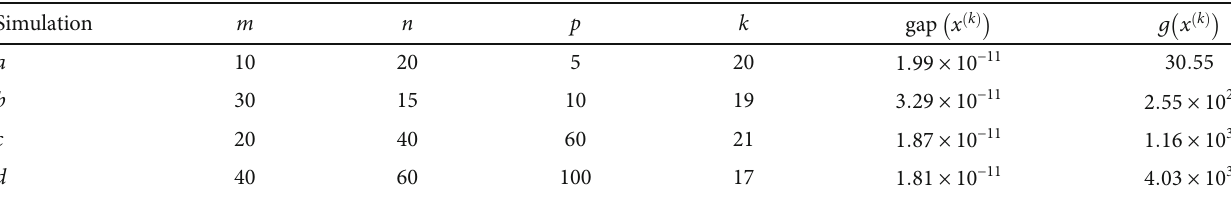
Table 6: Experiment 2: results of problem (7), given by Algorithm in